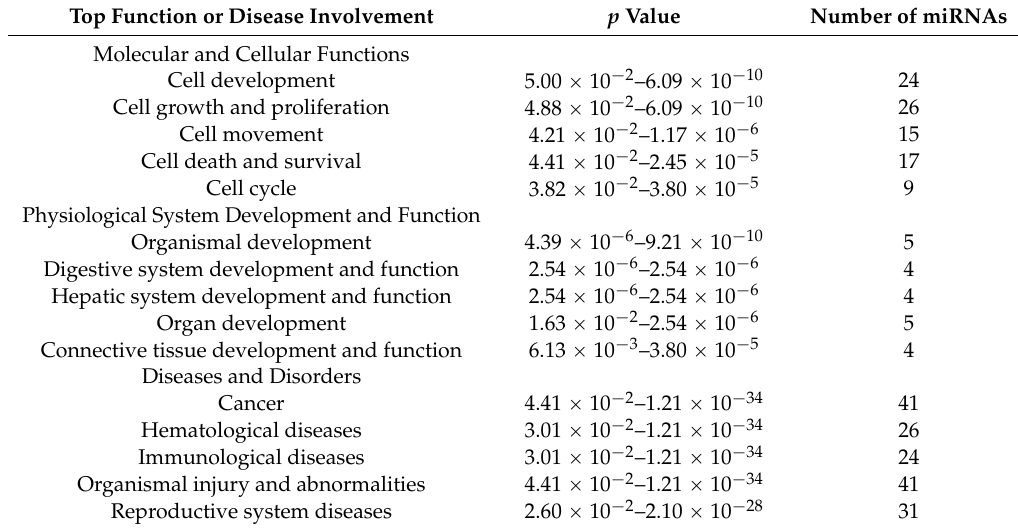
Table 5. Number of highly expressed experimentally validated known miRNAs (reads > 100K) involved in different molecular, cellular and developmental functions, or